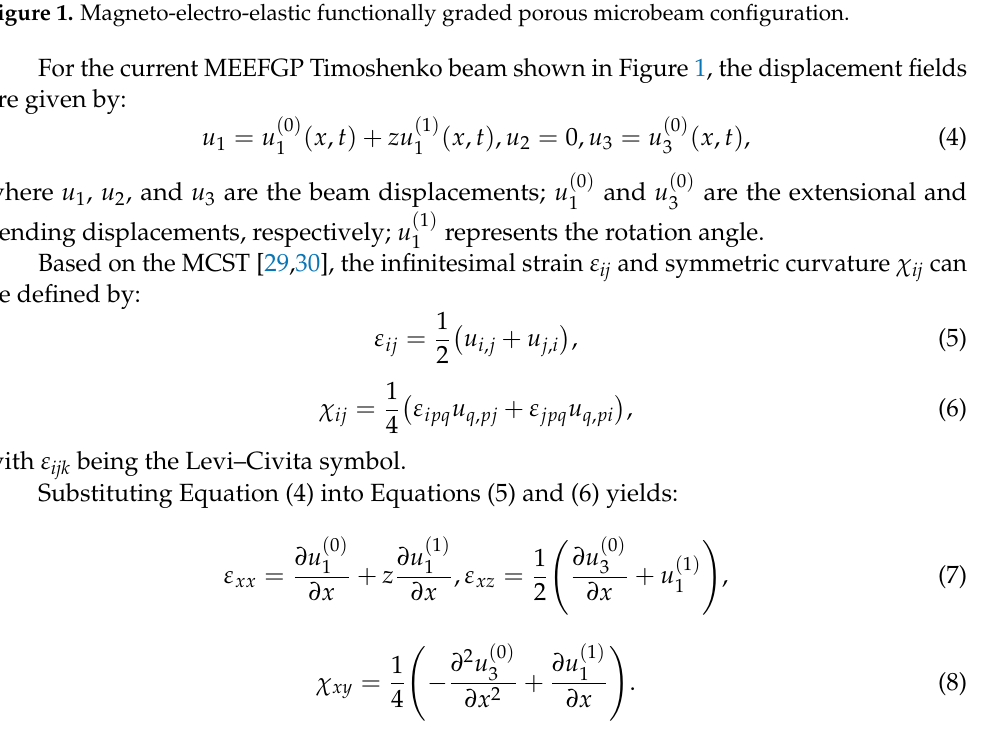
Figure 1. Magneto-electro-elastic functionally graded porous microbeam